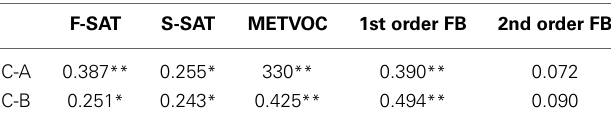
Table 1 | Descriptive statistics of the tasks performances. Age group